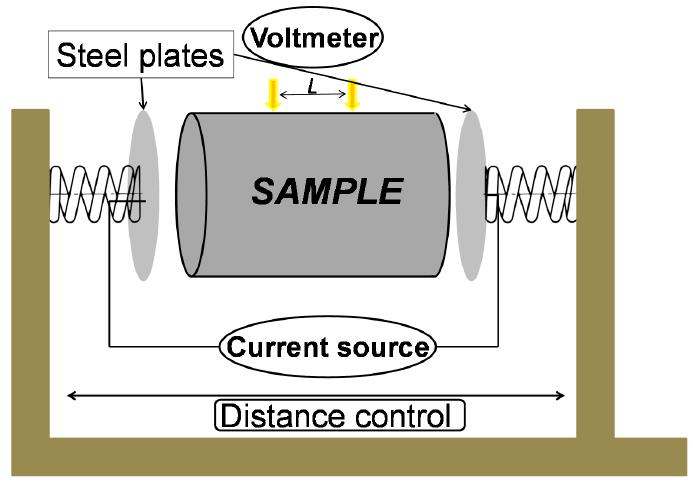
Figure 1. Schematic view of the setting used for the measurement of electrical resistivity of carbon anodes according to the ISO 11713 standard.